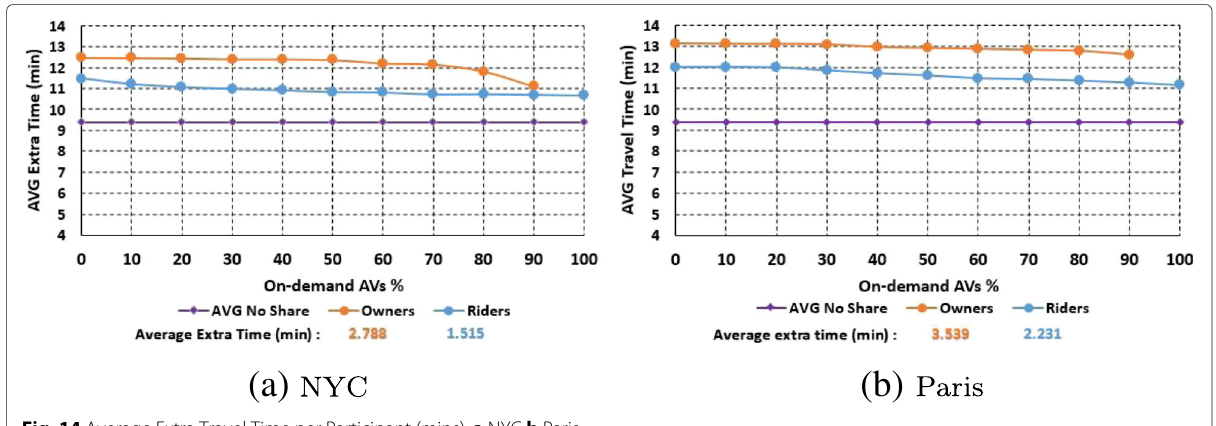
Fig. 14 Average Extra Travel Time per Participant (mins). a NYC b